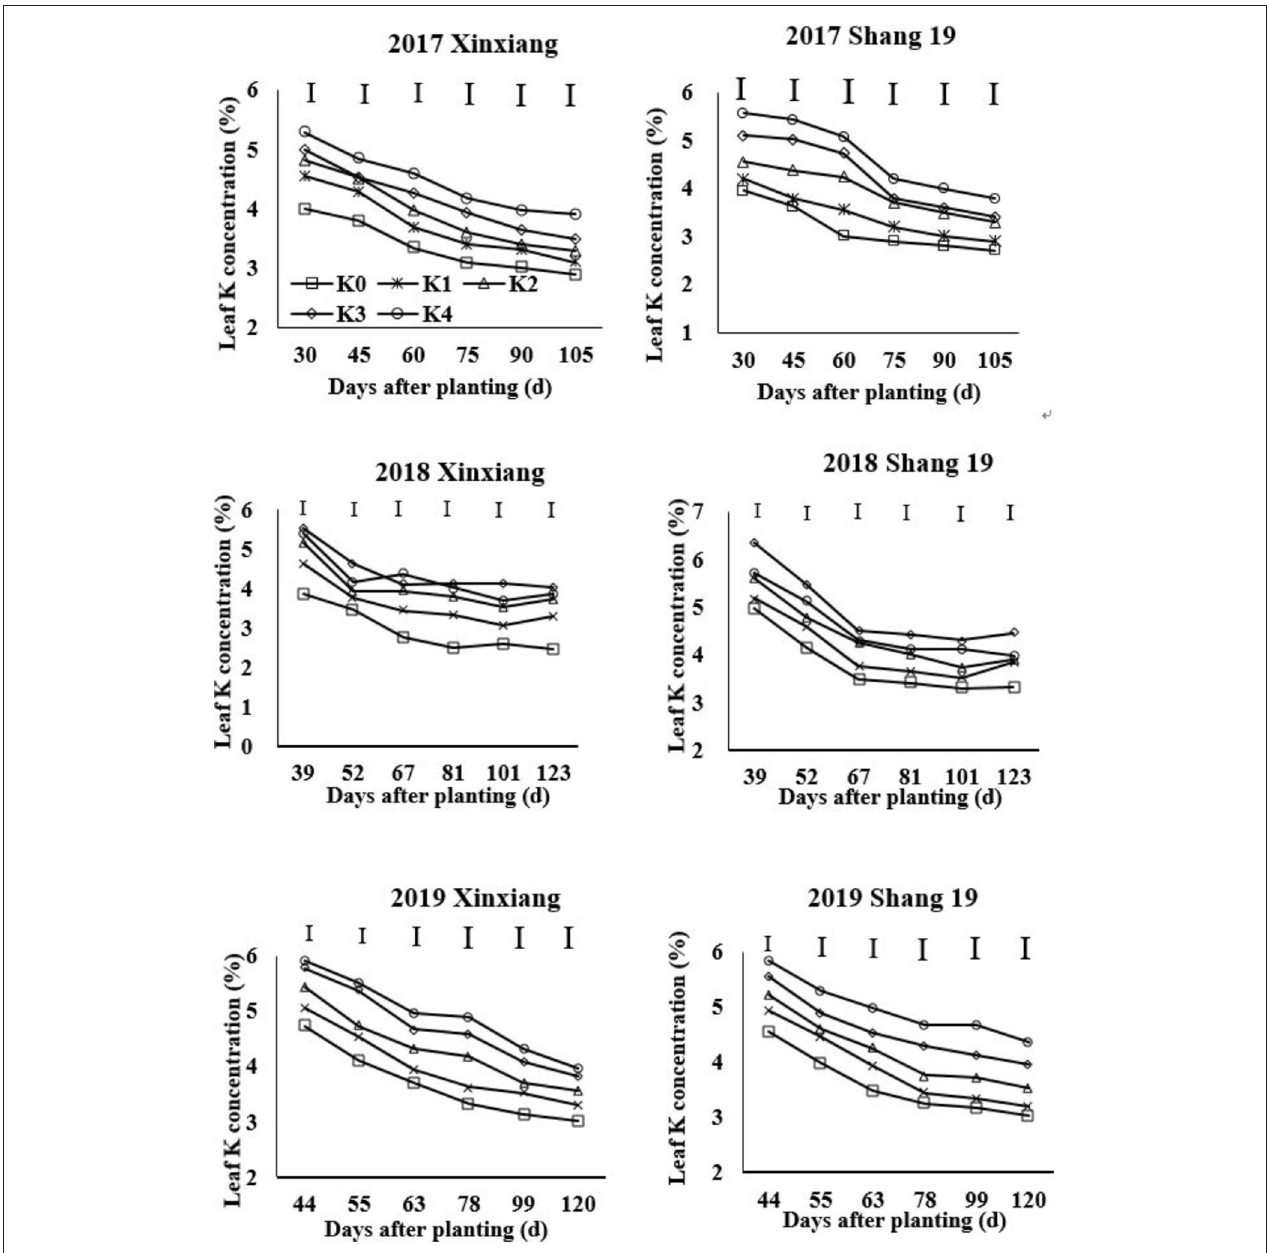
FIGURE 2 | Changes in K concentration in sweet potato leaves with time under different K fertilization